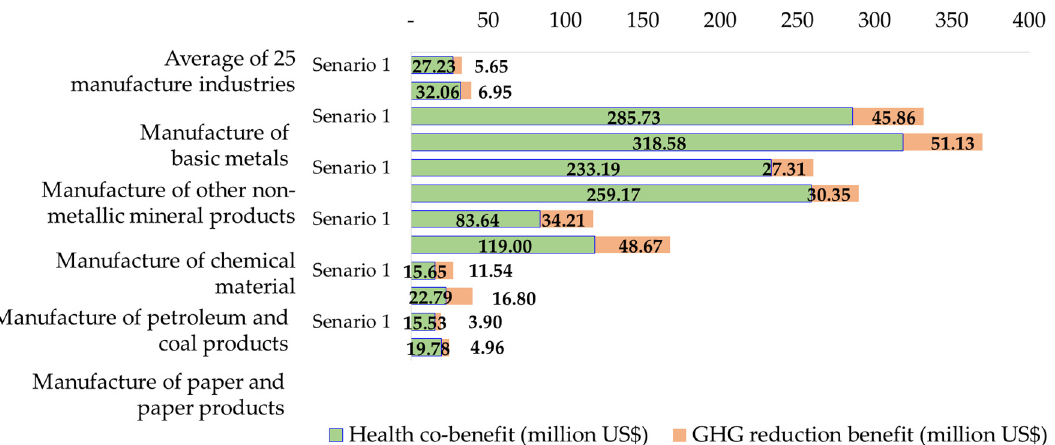
Figure 9. The benefits comparison for the top five groups of manufacturers for the two scenarios.